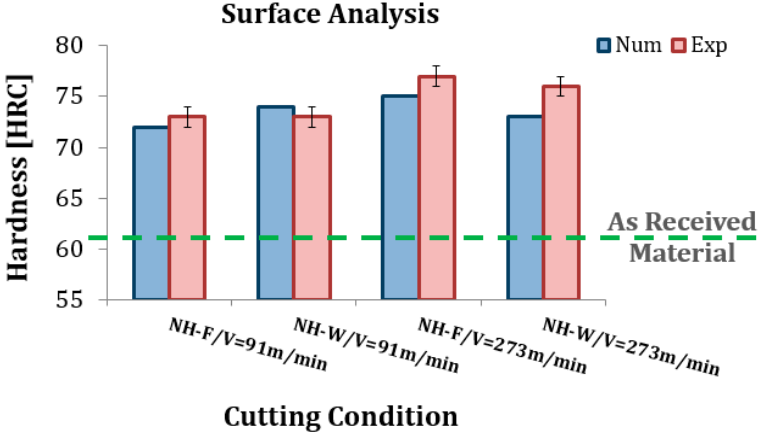
Figure 8. Surface hardness prediction (NH-W: negative rake worn insert, NH-F: negative rake fresh insert).